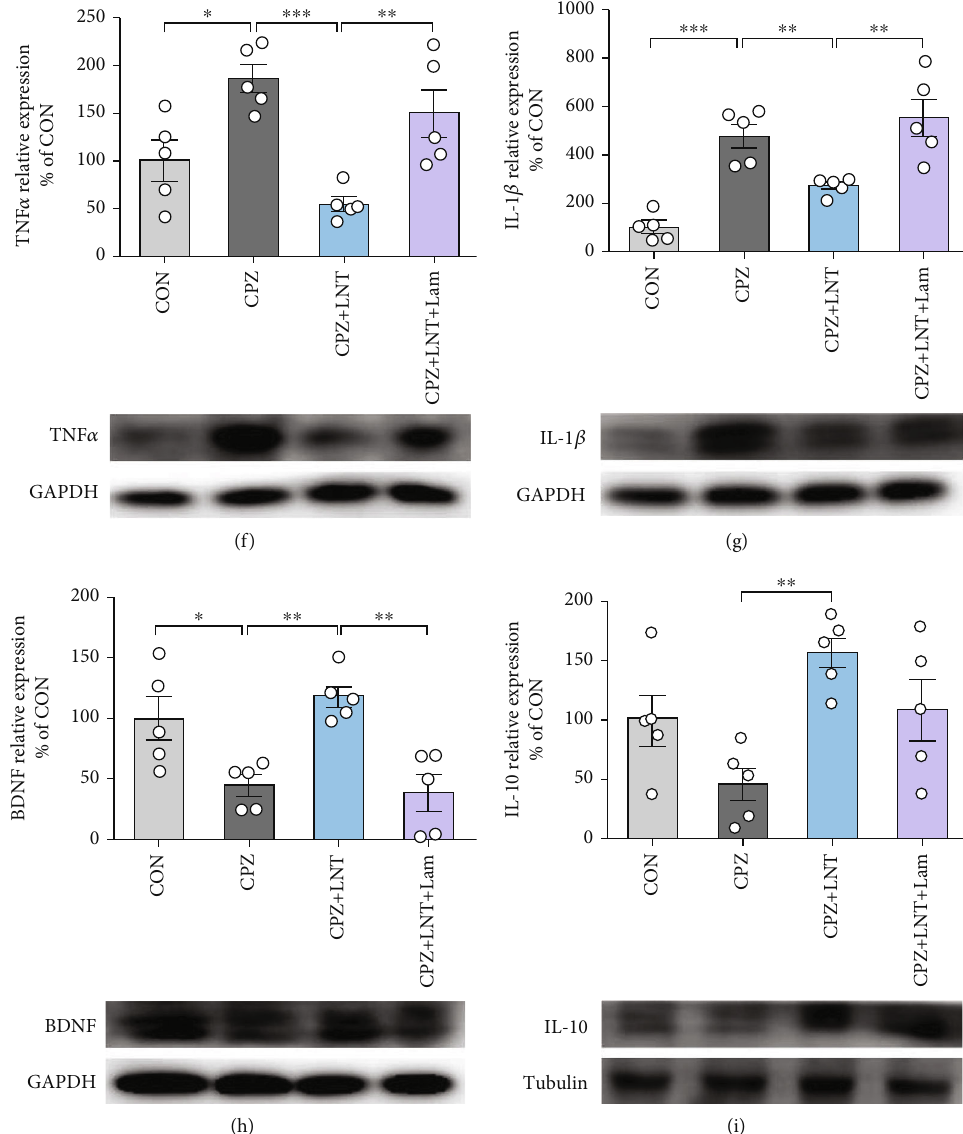
Figure 6: LNT ameliorated CPZ-induced variations in cytokine expression and glial cell activation by regulating the dectin-1 receptor. (a) Representative images and histogram of quantitative data of GFAP-positive cells, Olig2-positive cells, and Iba1-positive cells in the corpus callosum. Histogram of quantitative data of the protein expression levels of Olig2 (b), Iba1 (c), iNOS (d), Arg-1 (e), TNF- α (f), IL-1 β (g), BDNF (h), and IL-10 (i) was detected by Western blot. White arrows indicate representative cells in the treatment group. All data are presented as the mean ± SEM . Scale bar = 100 μ m (a). Statistical analysis was performed using one-way ANOVA followed by the post